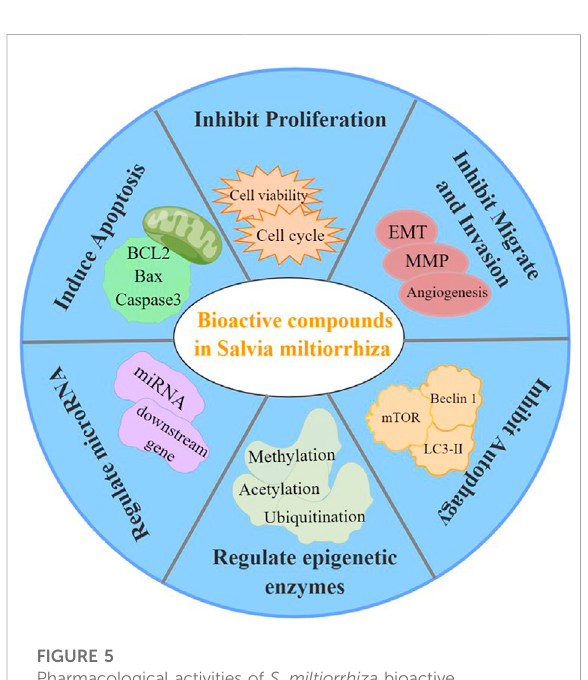
FIGURE 5 Pharmacological activities of S. miltiorrhiza bioactive compounds resulting in antitumor